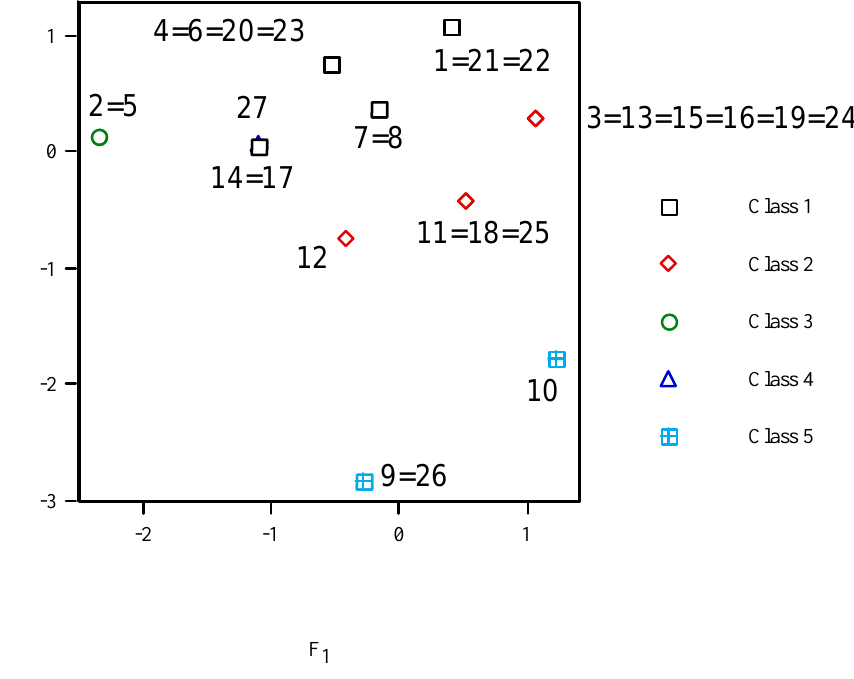
Figure 8. Principal component analysis F